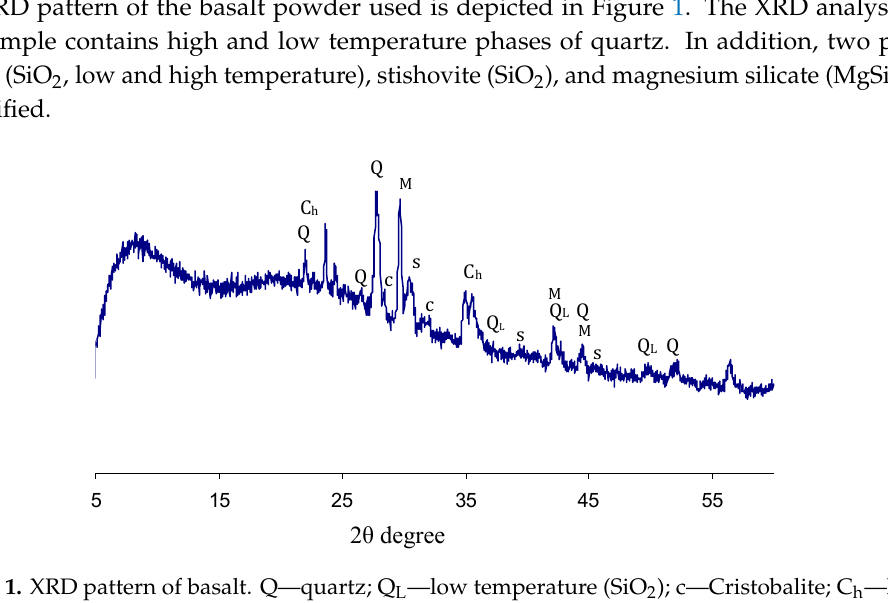
Figure 1. XRD pattern of basalt. Q—quartz; Q L —low temperature (SiO 2 ); c—Cristobalite; С h —high temperature (SiO 2 ); M—magnesium silicate MgSiO 3 ; s—Stishovite (SiO 2 ).